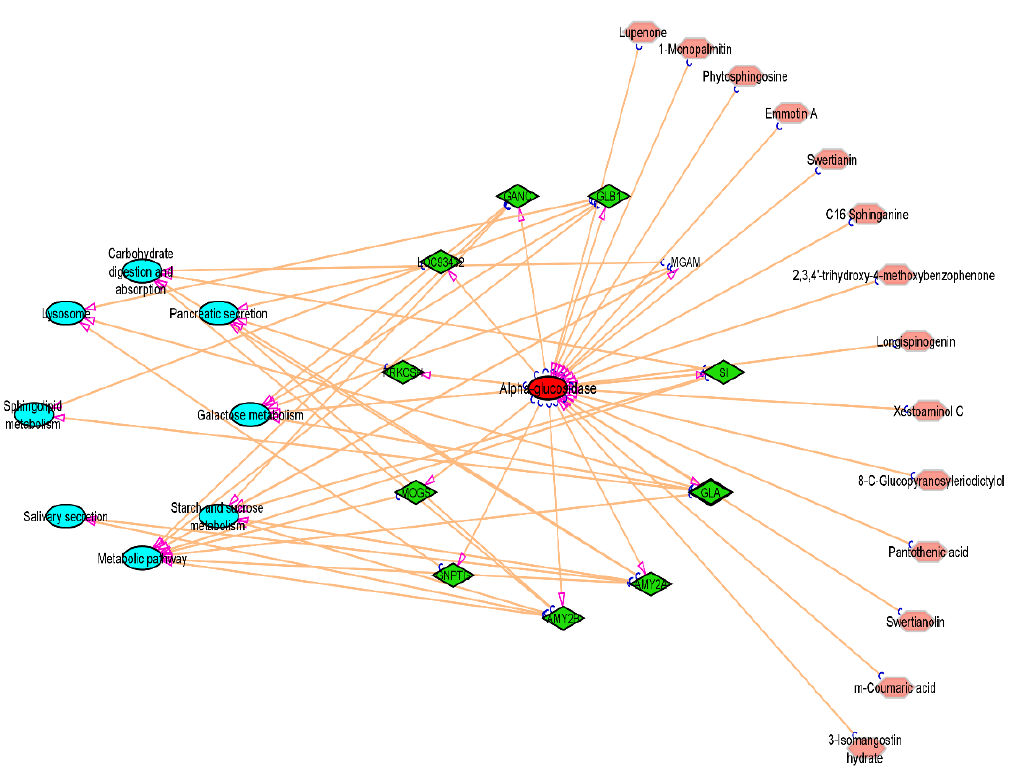
Figure 11. Network of protein interaction.